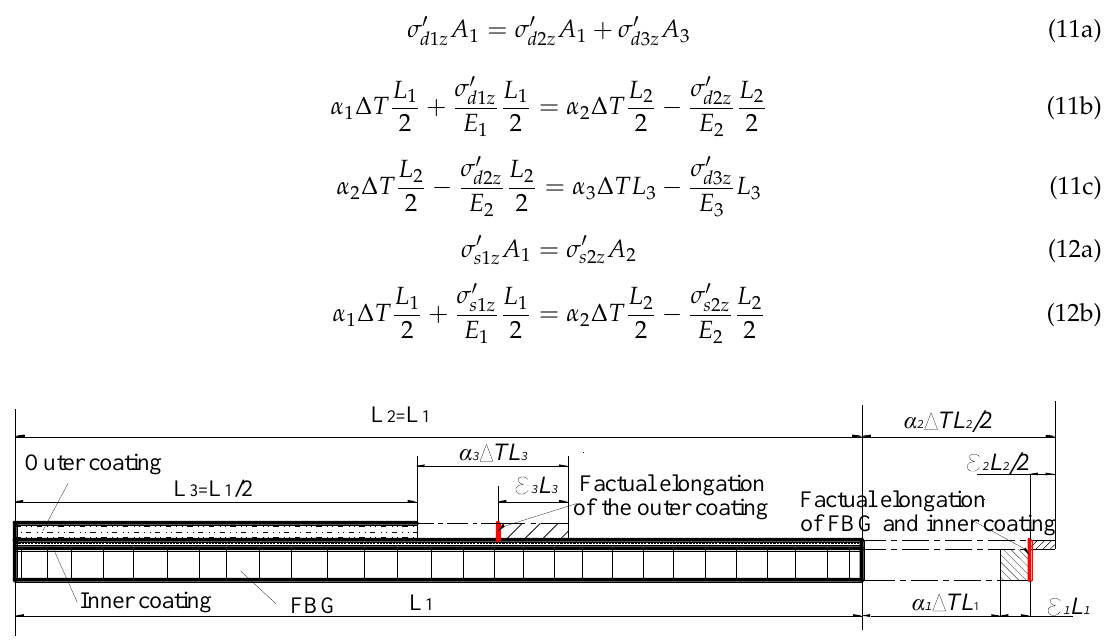
Figure 8. Diagram of the thermal strains of the Type B SMC-FBG.